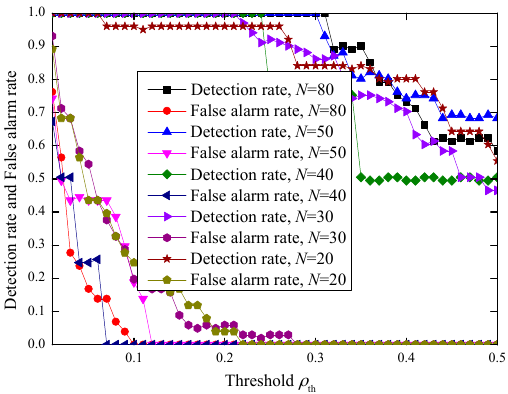
Figure 8. The impact of the frame number in an indoor environment, | ρ | > 0.3.